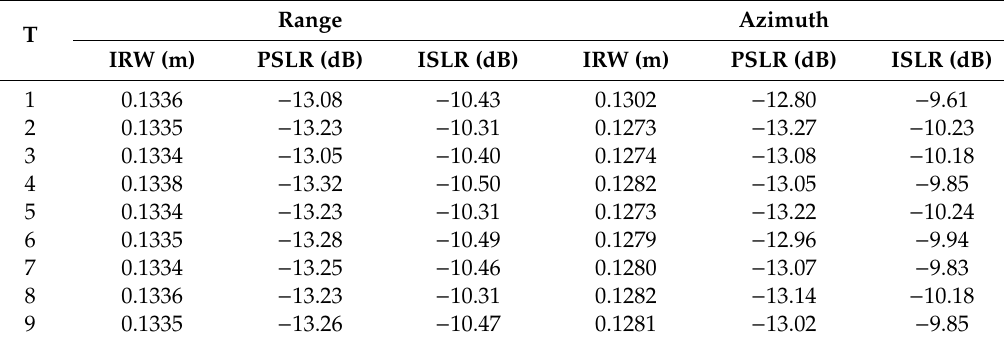
Table 4. Analysis of results with the proposed